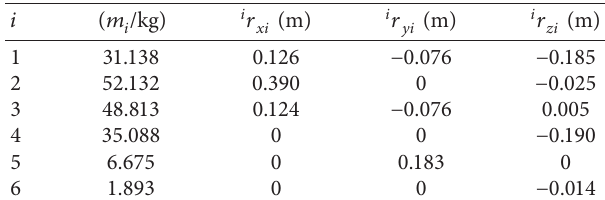
Figure 4: Coordinate systems of the robot. Table 2: The mass and centroid position of each